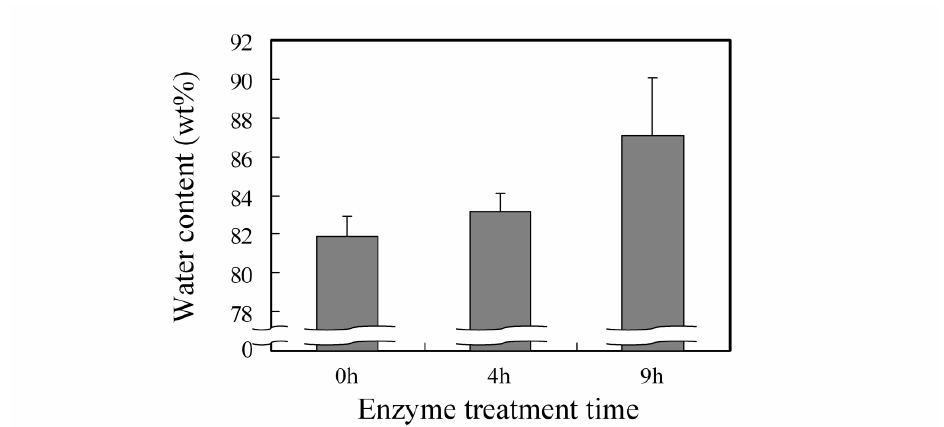
Fig. 7 Changes in water content in collagenase-digested articular cartilage before (0 h), after 4 hours (4 h), and after 9 hours (9 h) of collagenase digestion. Mean values (SD) are shown for the 0 h (n=10), 4 h (n=10), and 9 h (n=10) groups.